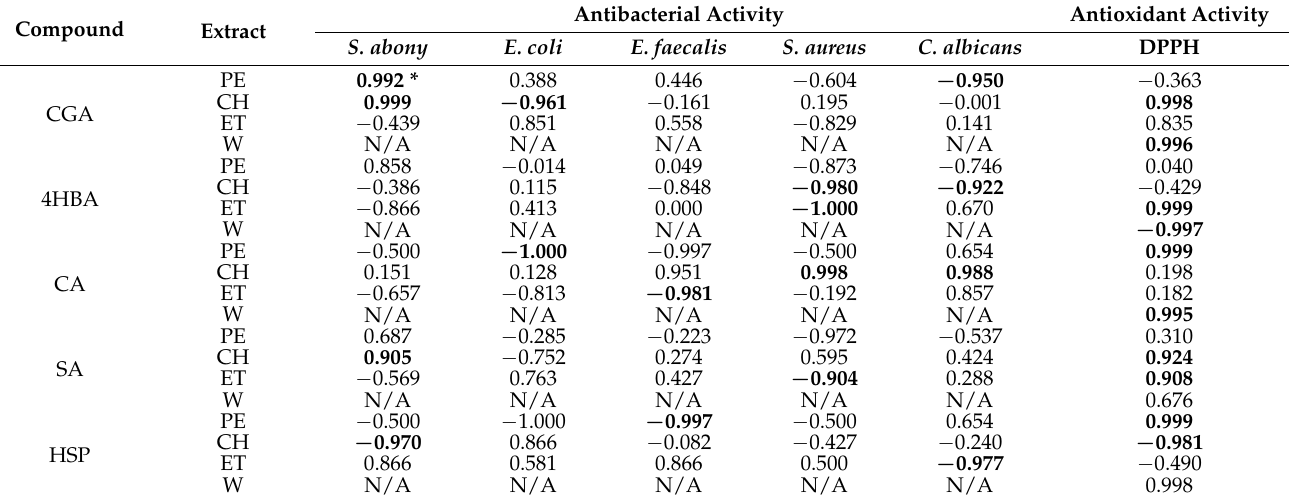
Table 4. Correlations of the most abundant phenolic compounds and antibacterial and antioxidant activities of extracts of G. lutea